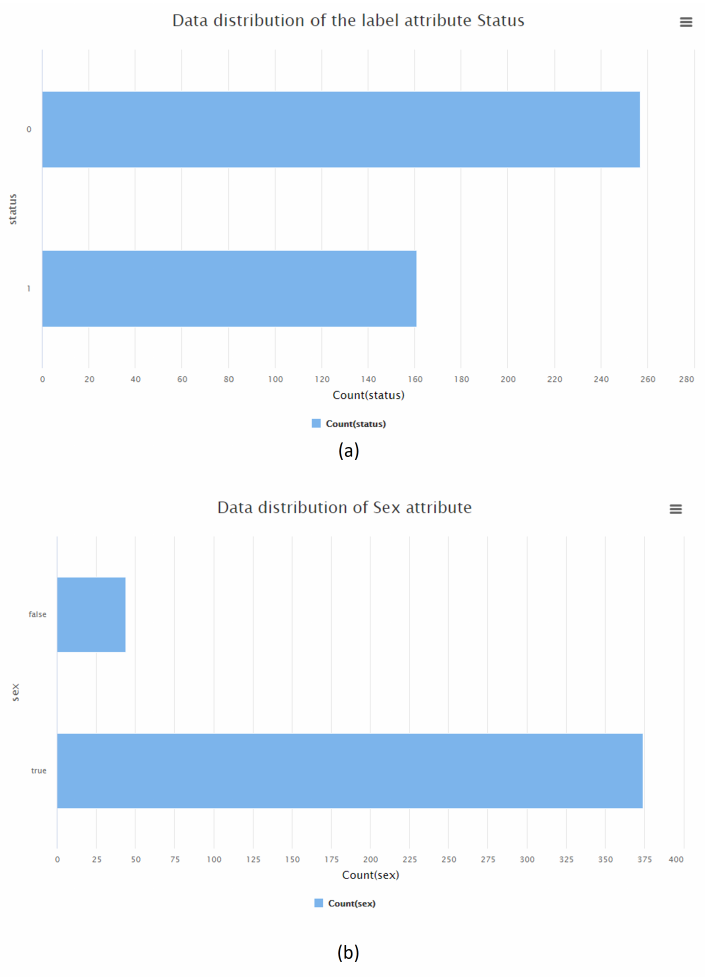
Figure 3. ( a ) Visualisation of the value discrepancy in the sex attribute. ( b ) Data distribution by